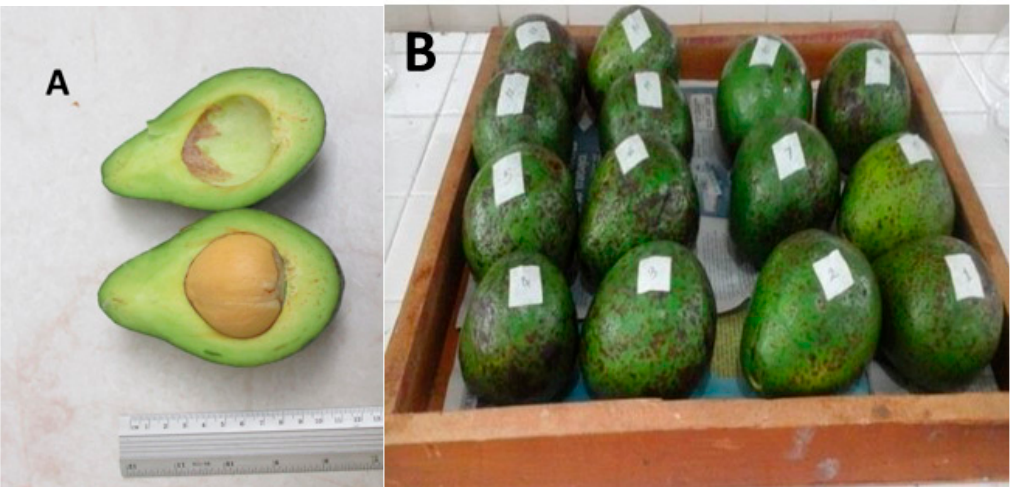
Figure 1. Avocado ( Persea americana ) ( A ) pulp and ( B ) fruit from Sandoná (Nariño,